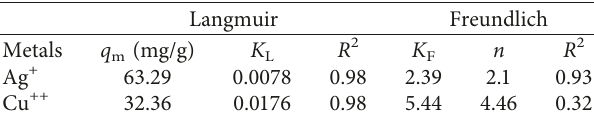
Figure 8: Linearized Langmuir isotherm models for Ag + and Cu ++ adsorption by the Saudi clay at 298K (clay mass 10g/L and shaking time 2 h). Table 2: Langmuir and Freundlich parameters obtained from the plots of Ag + and Cu ++ adsorption onto Saudi clay at 298K.